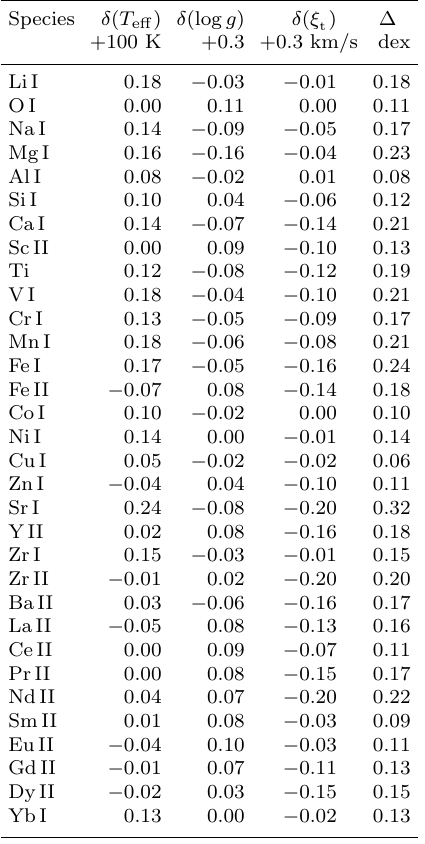
Table 4. Systematic errors in the abundances produced by the uncertainties in the atmospheric